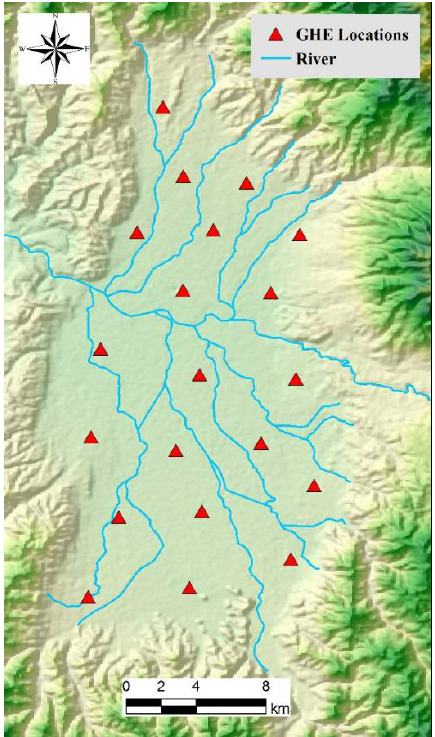
Figure 6. Locations of ground heat exchanger models.